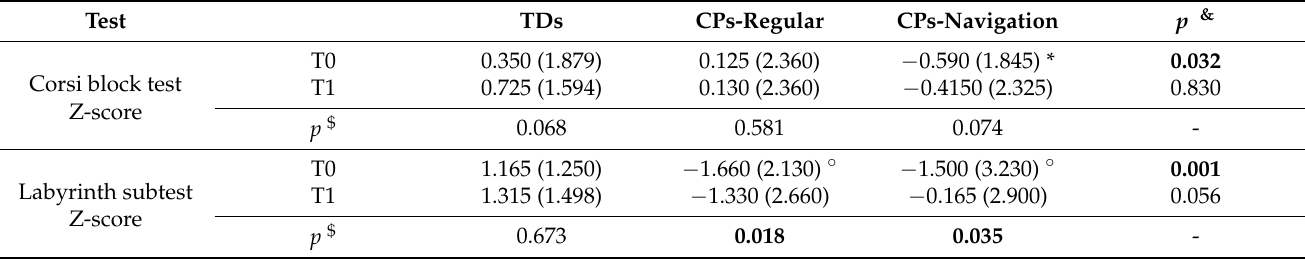
Table 2. Visual spatial competences in CP and TD participants at T0 and